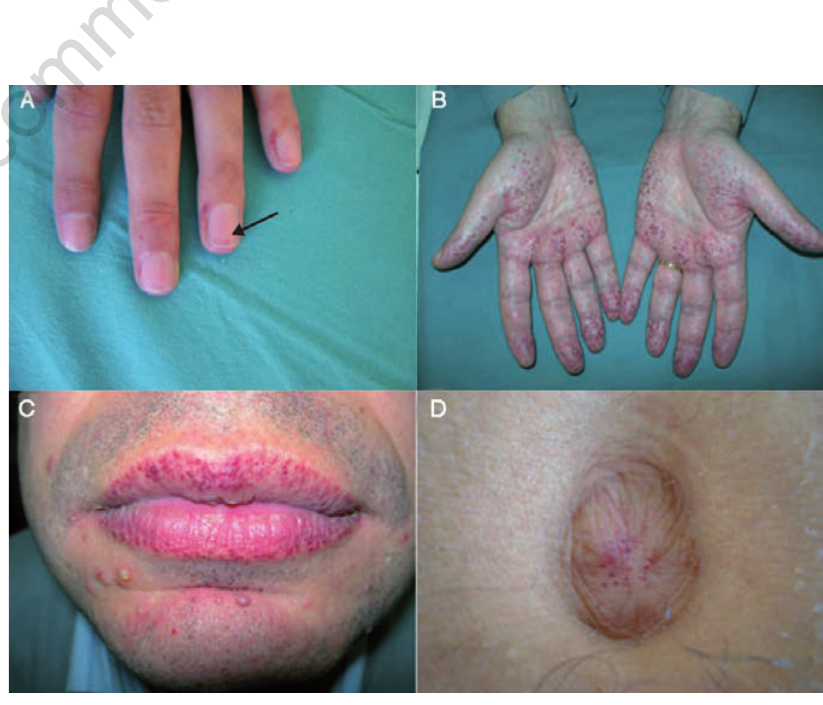
Figure 3. Various aspects of angiokeratoma in Anderson-Fabry disease patients: angioker- atoma of the periungual and subungual area (panel A), of the palms, lips and umbilicus (panel B-D respectively) ( Reprinted with permission of the publisher from Zampetti et al. 39